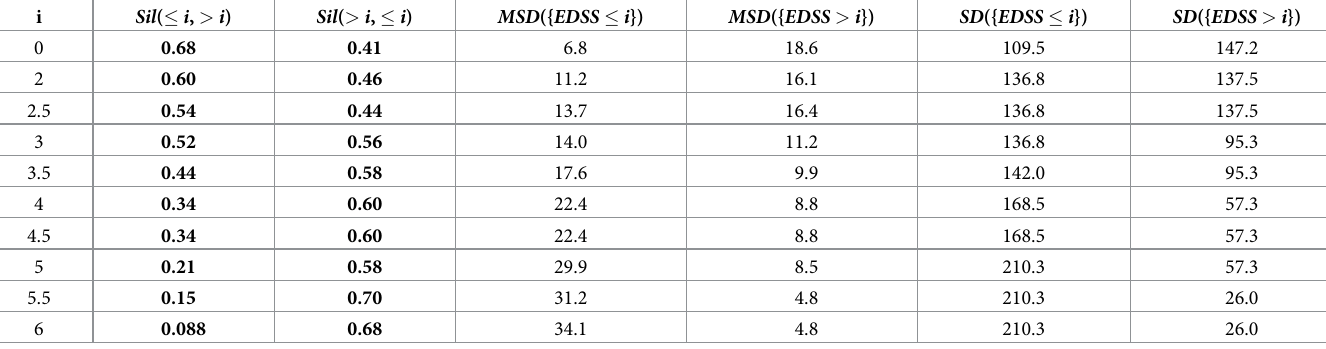
All silhouette scores are positive. For each i , at least one of the two silhouette scores Sil